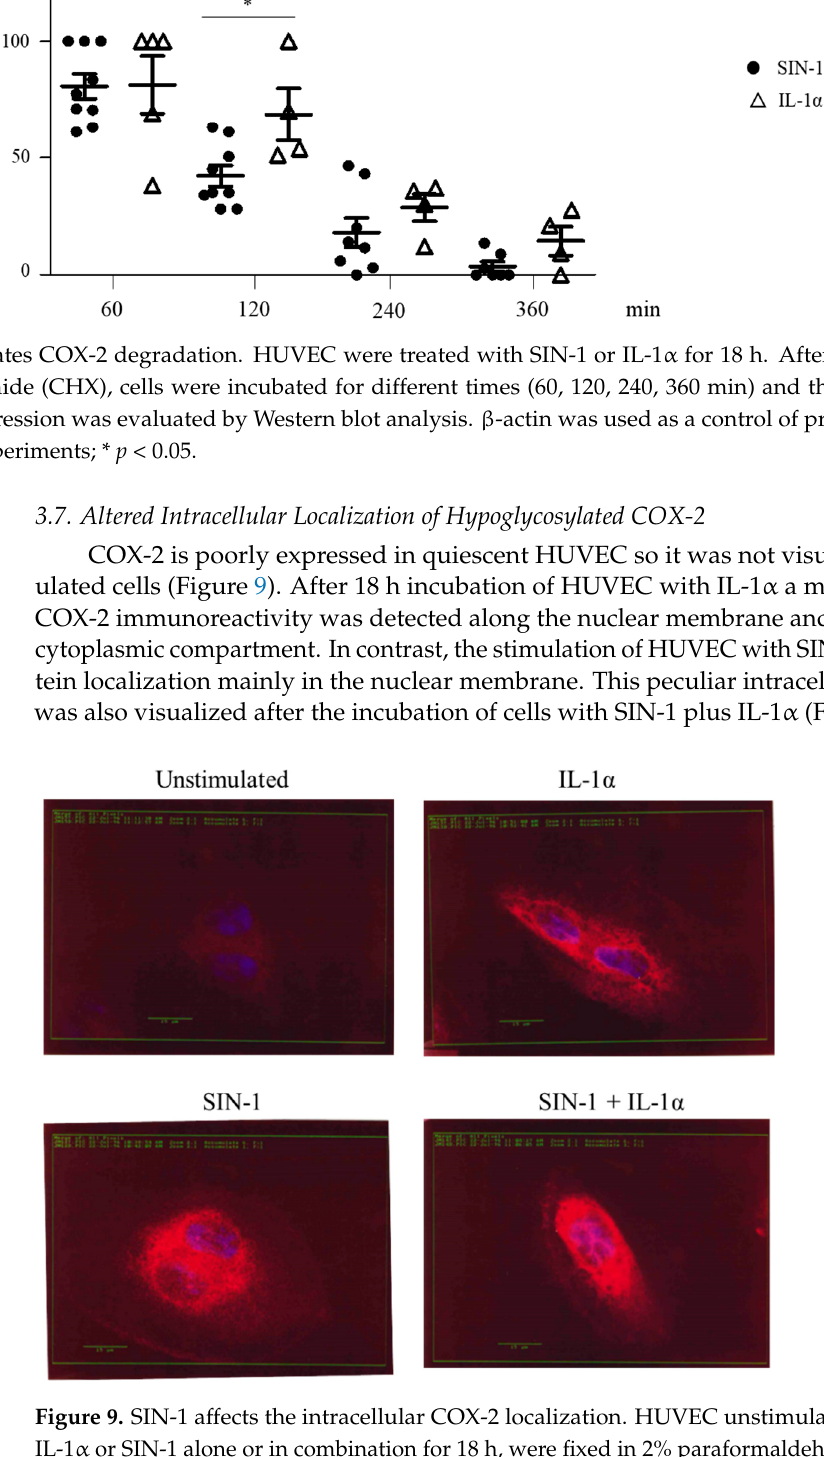
for COX-2 (in red). Nuclei (in blue) were visualized by Hoechst 33258. Images (400 x magnification) are representative of 3 independent experiments.